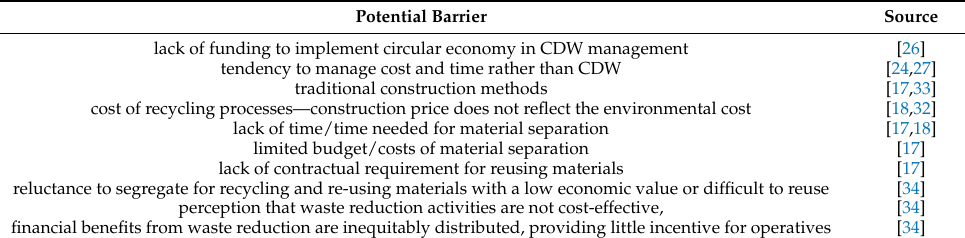
Table 2. Summary of economic barriers to increasing CDW recycling and